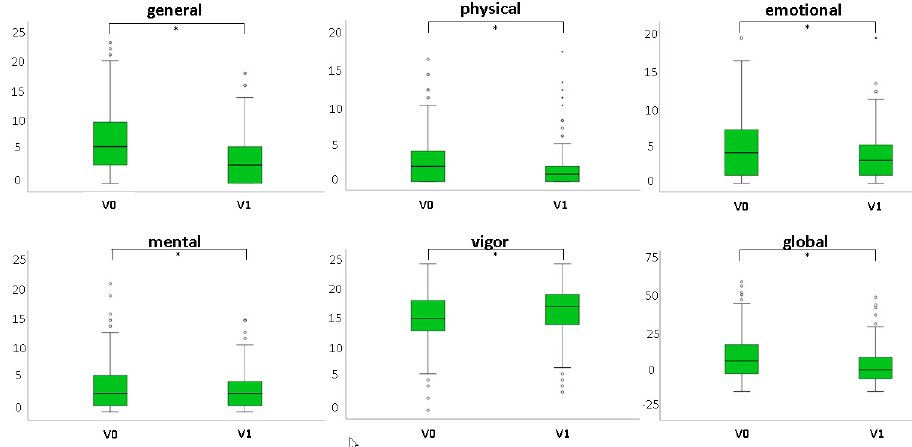
Figure 3. Comparison of median and 1 st / 3 rd quartiles for the fatigue scales before (V0) and after (V1) IV or oral iron therapy. For the 4 scales general, physical, emotional and mental a lower level indicates an improvement, for the scale vigor a higher level indicates an improvement (* p < 0.001 for all, n = 160).